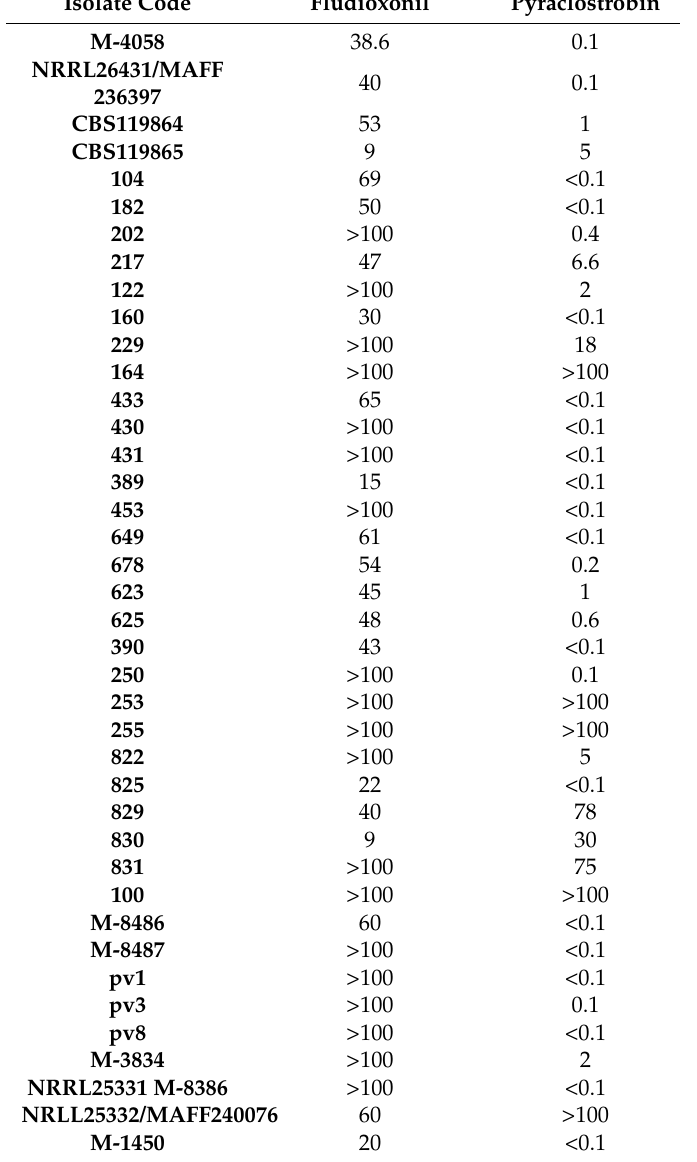
Table 2. Mean values (ppm) for half-maximal effective concentration (EC 50 ) for each fungicide on mycelial growth of F. circinatum